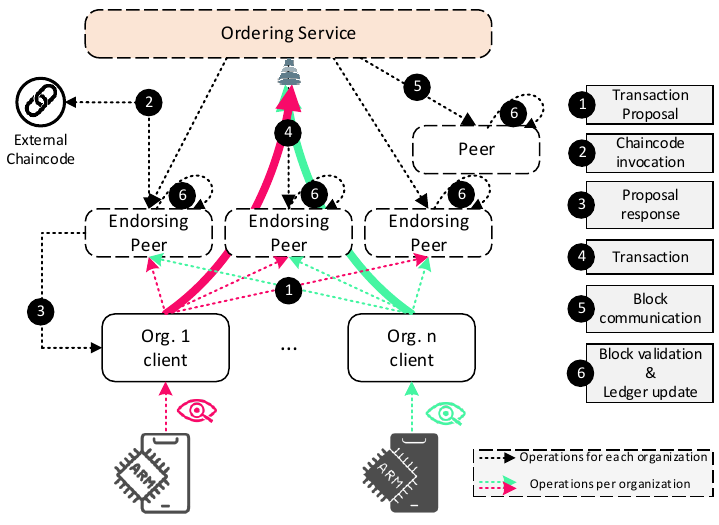
Fig. 4. HLF-Kubed monitoring system